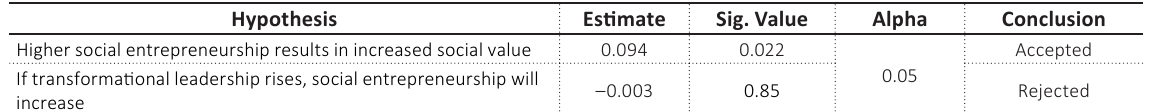
Table 5. Hypothesis